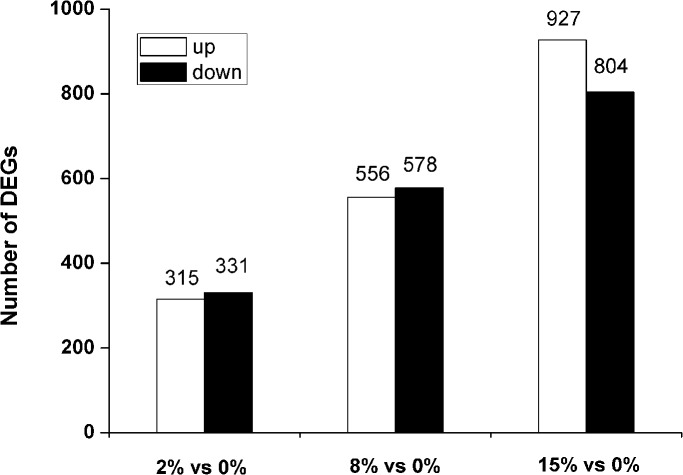
Statistical chart of Bacillus sp. N16-5 differentially expressed genes (DEGS) in response to salt stress.Compared to the transcriptional level at 0% NaCl, 315 genes and 331 genes were up-regulated and down-regulated, respectively, at 2% (w/v) NaCl. At 8% (w/v) NaCl, 556 genes and 578 genes were up-regulated and down-regulated, respectively, whereas 927 genes were up-regulated and 824 genes were down-regulated at 15% (w/v) NaCl.